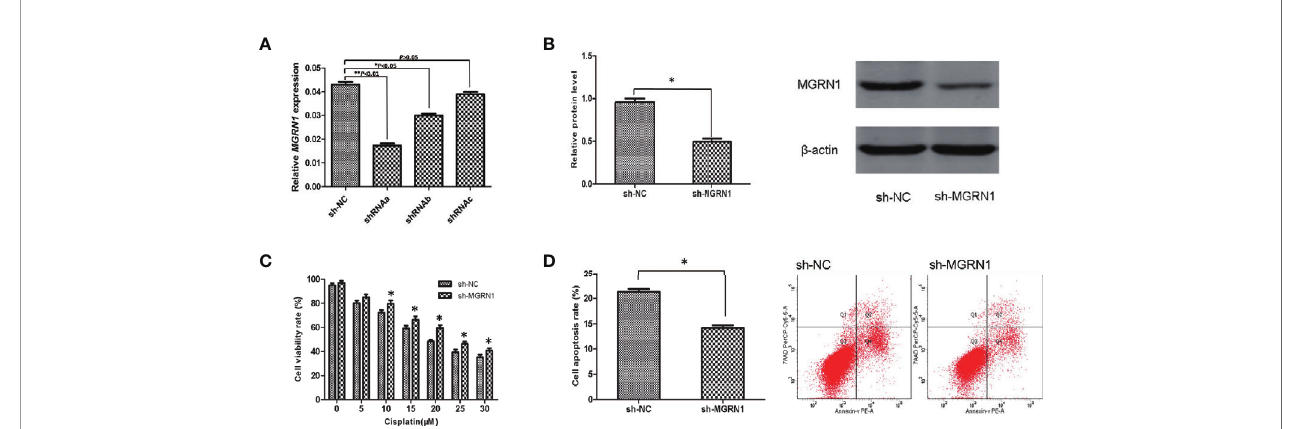
FIGURE 2 | The alteration of the sensitivity to cisplatin after a knockdown of MGRN1 expression in SKOV3 cells. (A) RT-qPCR assay showed the reduced expression of MGRN1 in shRNAa- MGRN1 , shRNAb- MGRN1 and shRNAc- MGRN1 cells compared to shNC cells. (B) Western blot assay showed the reduced expression of MGRN1 in shRNAa- MGRN1 cells compared to shNC cells. (C) CCK-8 assays showed a signi fi cant increase in the proliferation rates in the shRNA- MGRN1 cells compared with the shNC cells after cisplatin treatment at several concentrations for 24h. (D) Flow cytometry showed that the apoptosis rate in the